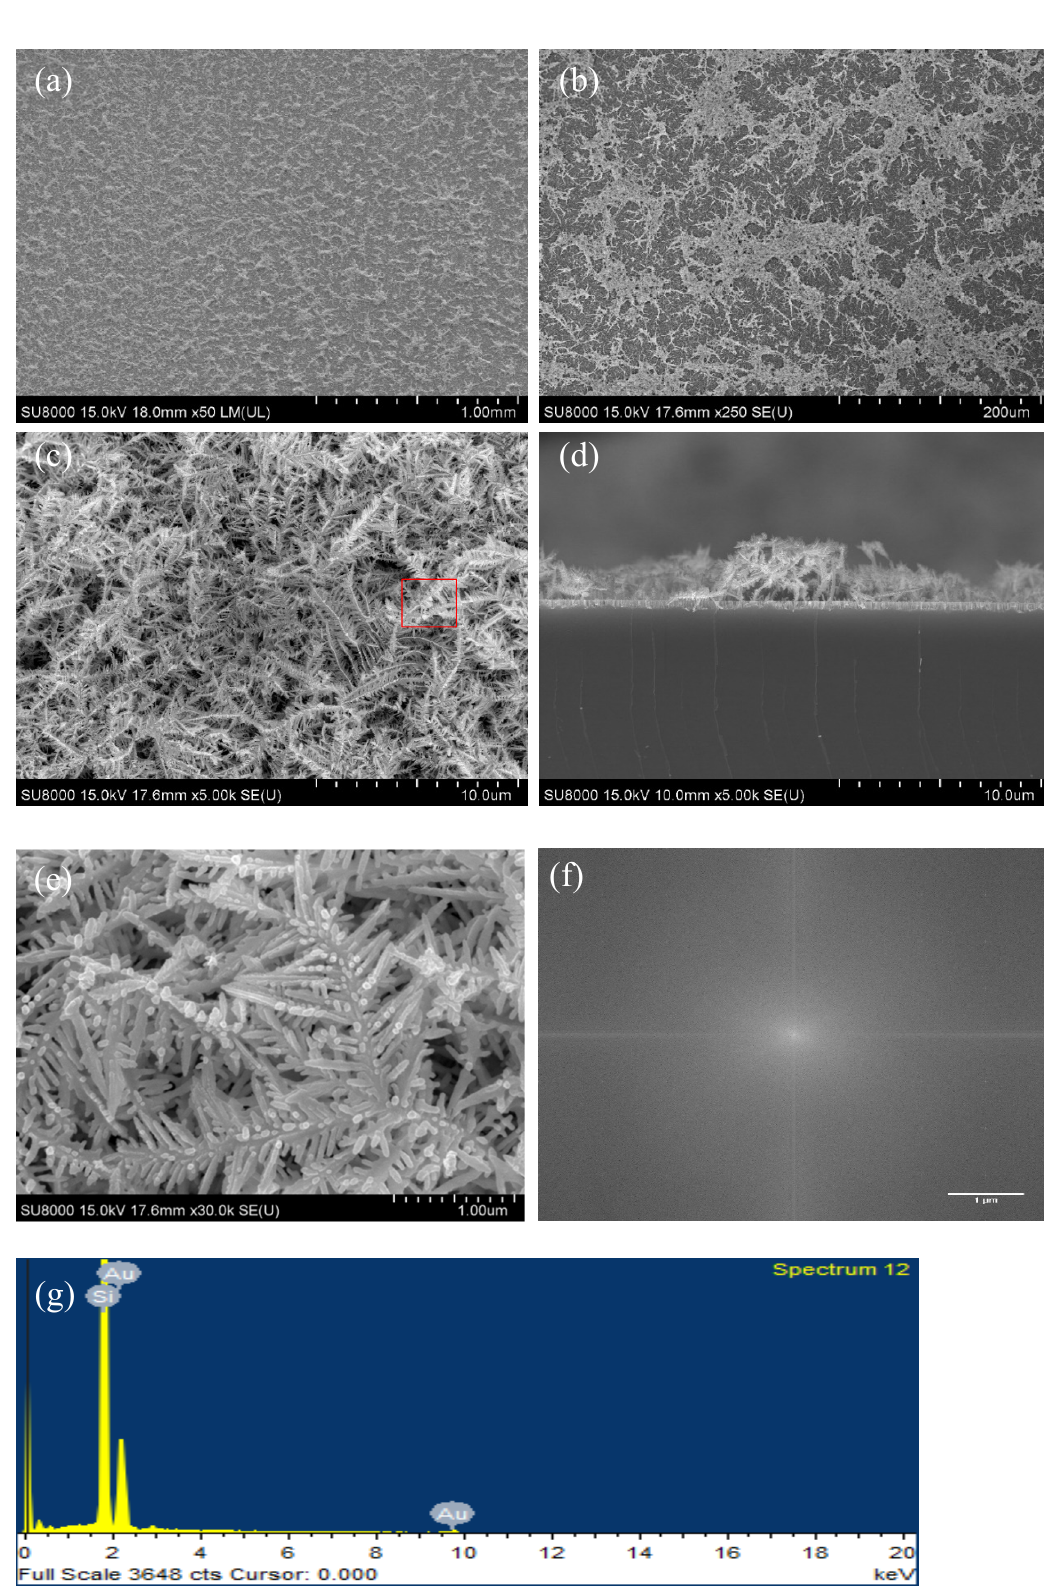
Figure 2. SEM pictures of the Au DNFs/Si chip. ( a ) 50 × top view; ( b ) 250 × top view; ( c ) 5000 × top view; ( d ) 5000 × side view; ( e ) zoom-in image for FFT; ( f ) FFT image of ( e ); ( g ) EDS spectrum of the marked region in ( c ).